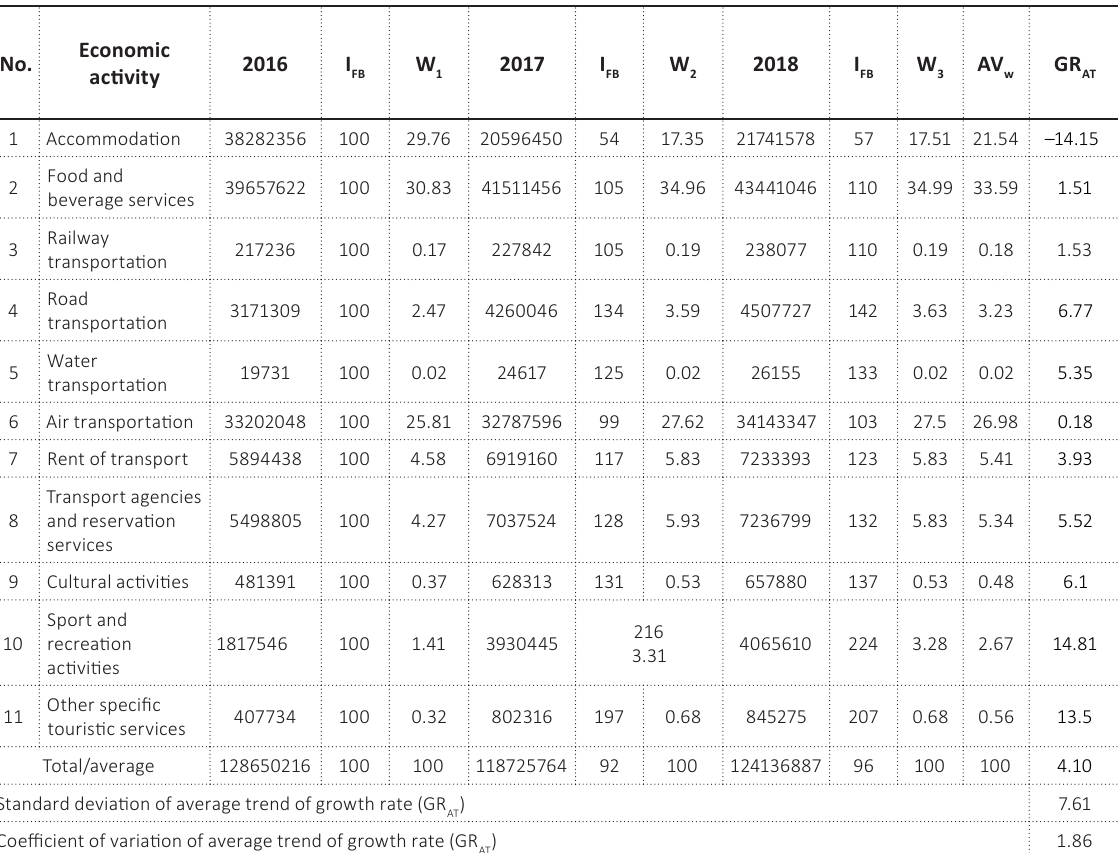
Note: GDP at producers’ value and at current price. Table A2. Weights and composition trend of tourism revenue in Saudi Arabia (million Riyals)